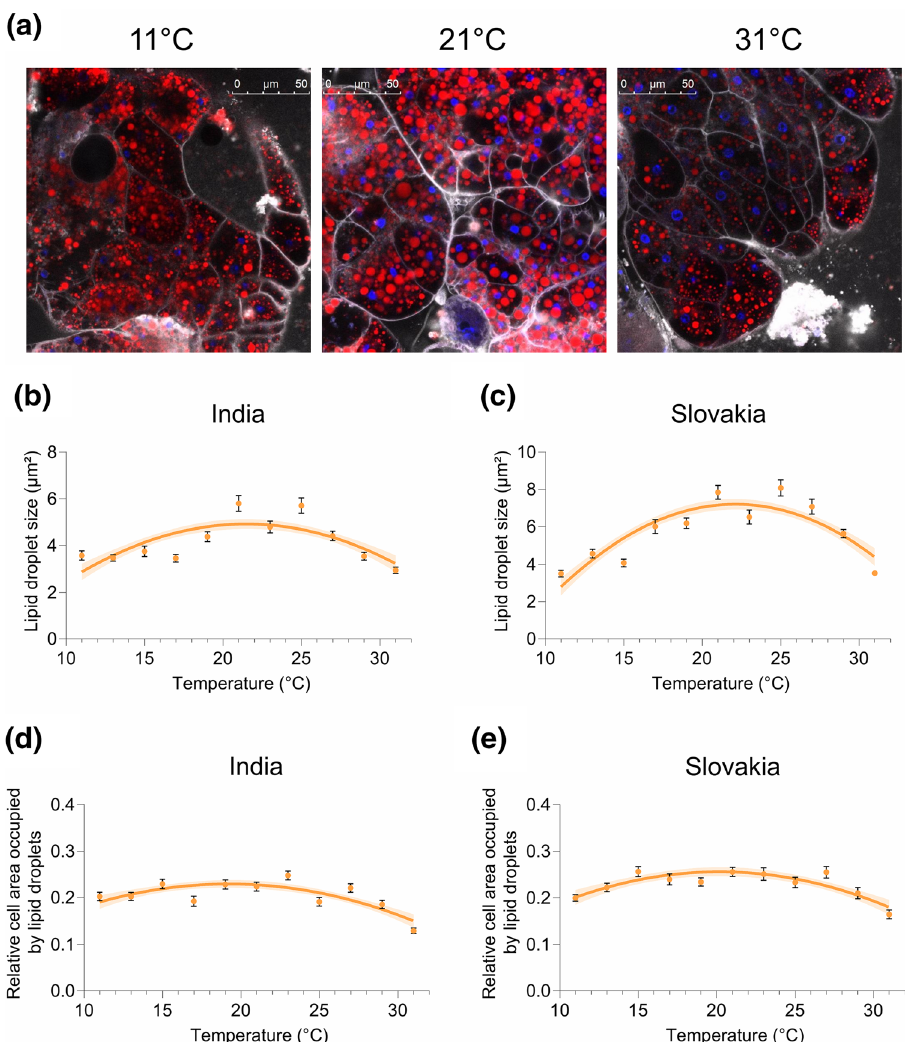
Figure 5. Temperature affects lipid droplet size and the relative cell area occupied by lipid droplets. ( a ) Confocal images of the fat body of Drosophila exposed to different temperatures; lipid droplets in red (Bodipy 493/503), cell membranes in white/grey (CellMask Deep Red), and DNA in blue (Hoechst 33342). ( b , c ) The relationship between temperature and lipid droplet size in flies from India ( b ) and Slovakia ( c ). ( d , e ) The effect of temperature on the relative cell area occupied by lipid droplets (a ratio between the area covered by lipid droplets and the total area of a given cell measured in a single optical section) in flies from India ( d ) and Slovakia ( e ). Data points are mean values ± s.e.m.. Lines represent a quadratic fit to data with the 95% confidence band. For statistical analyses, see Supplementary Tables S11,